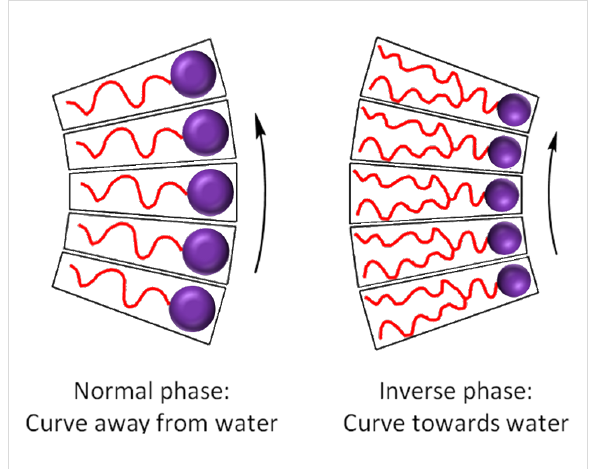
Each of these applications requires a specific, stable liquid-crys- talline phase. The phase behaviour can have a significant impact on performance for the end application with, for example, drug- release rates known to vary depending on the geometrical char- acteristics of the lyotropic phase [12]. Increasing the lattice parameter of the liquid-crystalline phase may also facilitate the uptake of larger bioactive molecules [4].